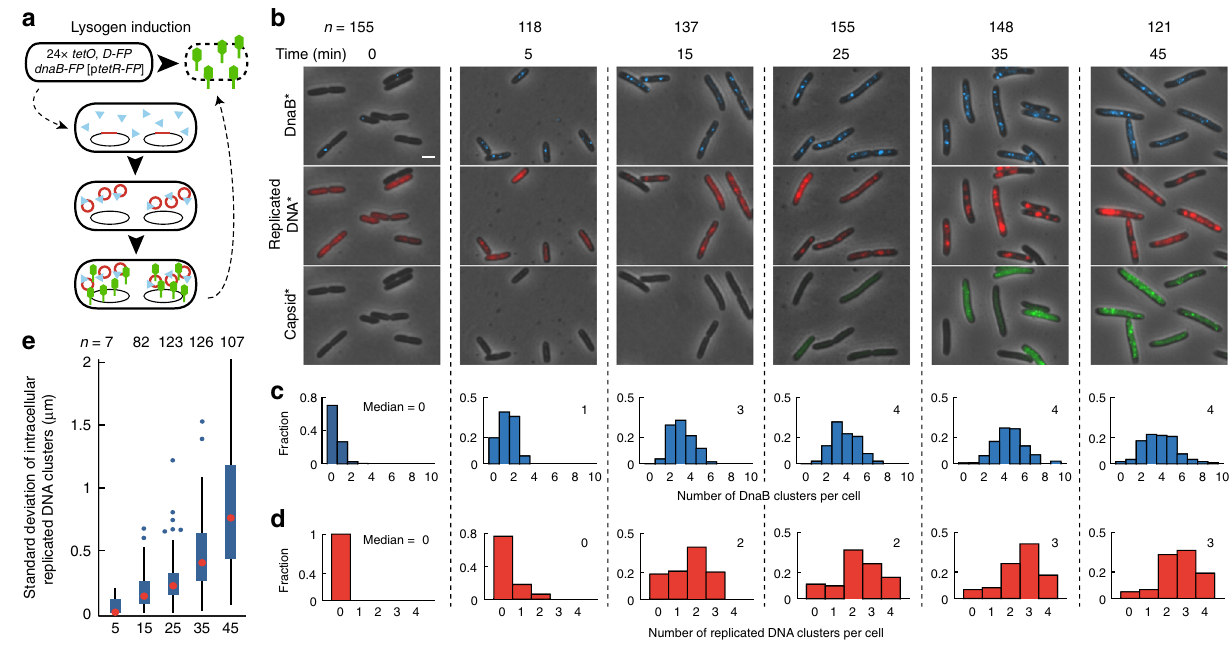
Fig. 2 Organization of multiple heterogeneous subcellular areas during phage induction. a Schematic for the spatial organization of phage development after induction. Lambda prophage is integrated into the bacterial chromosome, and different copies of the chromosome locate to different areas of the cell during growth. Induction of lysogens forces phages to develop in different areas of the cell. The prophage bears the gpD-mNeongreen lytic reporter and carries a tetO array. The cell harbors a TetR-mCherry plasmid and a DnaB-mTurquoise2 reporter. b Overlay images of lysogens after induction. At 0 min the cells were not yet induced (*indicates that the contrast is adjusted for each time point shown for clarity). All scale bars in this fi gure are 2 μ m. c , d Intracellular areas of phage DNA and DnaB form. Histograms of the number of DnaB ( c ) and replicated DNA clusters ( d ) are shown for each time point. e Phage DNA replication varies intracellularly. For cells with more than one DNA cluster, the standard deviation of the size of the clusters is represented in boxplots for each time point, as a measure of intracellular phage DNA variability. The median is indicated by the dot at the center of the box, the box bounds the interquartile range of the data, the whiskers span the range of the data excluding the outliers, and the outliers are indicated as individual points. The approximate limit of our resolution is around 250 nm. Source data are provided as a Source Data fi